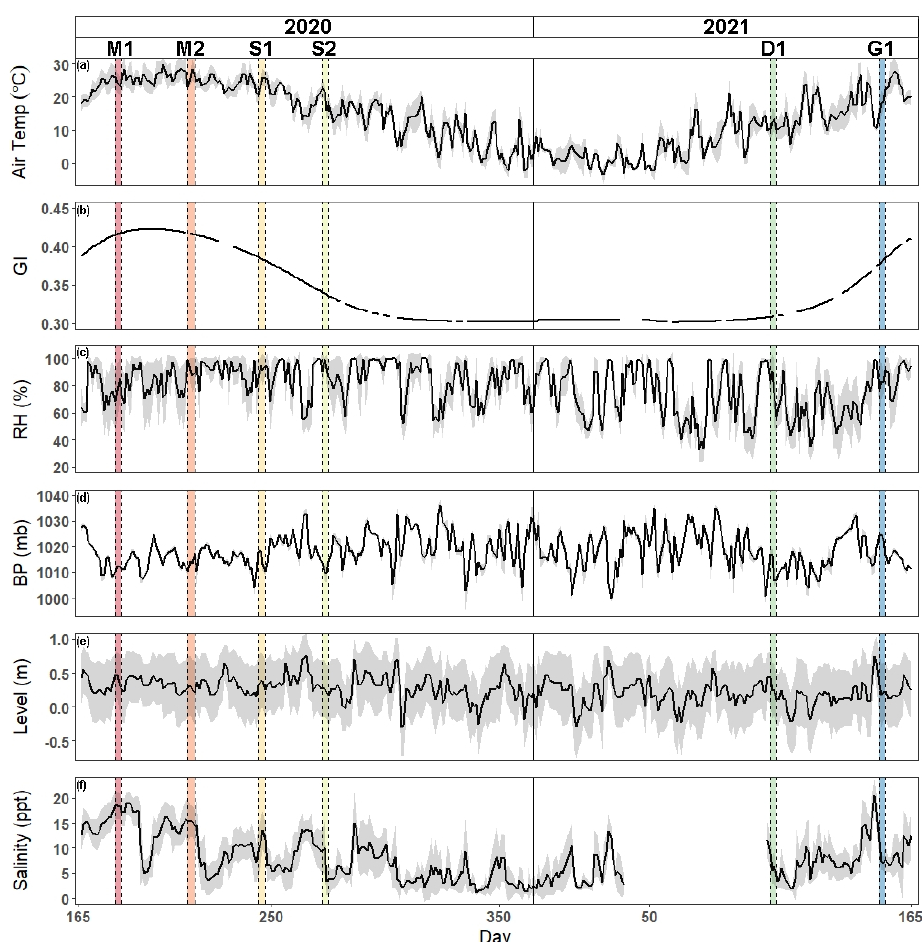
Figure 1. Time series of hourly mean ± SD gray shaded region of (a) air temperature, (b) greenness index, (c) relative humidity, (d) baromet- ric pressure, (e) water level, and (f) salinity from 14 June 2020 to 14 June 2021. Vertical shaded areas correspond to each of the campaigns (M: maturity; S: senescence; D: dormancy; G: